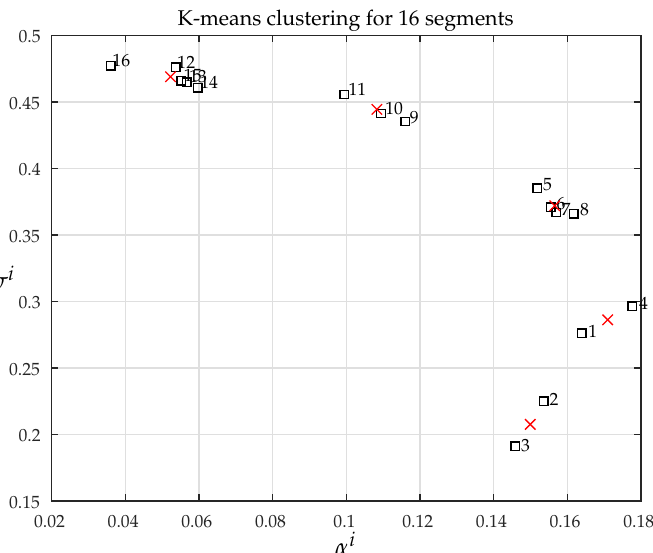
Figure 6. Result of k -means clustering with five categories. Cluster centers are indicated by red crosses.